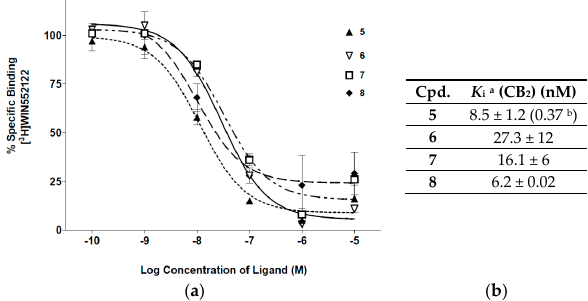
Figure 1. ( a ) Individual competition binding curves of compounds 5 , 6 , 7 , and 8 . Inhibition of [ 3 H]WIN55.212-2 binding by increasing concentrations (100 pM to 10 µM) of compounds 5 , 6 , 7 , and 8 to membrane homogenates of CHO cells stably transfected with human CB 2 . Each value represents the mean ± standard deviation of a triplicate in a single experiment; ( b ) Binding affinity ( K i ) of compounds 5 , 6 , 7 , and 8 for the human cannabinoid receptor type2 (CB 2 ) receptor. a Values are means ± standard deviations of two to three experiments run in triplicate; b K i of compound 5 as reported in [23].